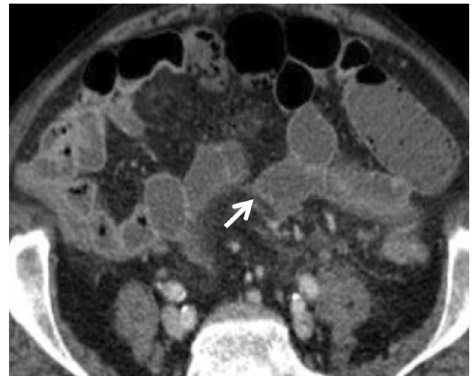
Fig. 7 Bowel wall enhancement. Contrast-enhanced axial CTscan shows normal dilated loops with a diffuse hypointense segment of small bowel